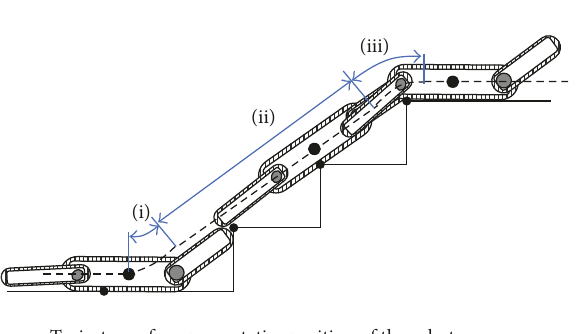
Figure 1: Assumed shape of the robot and the stairs.